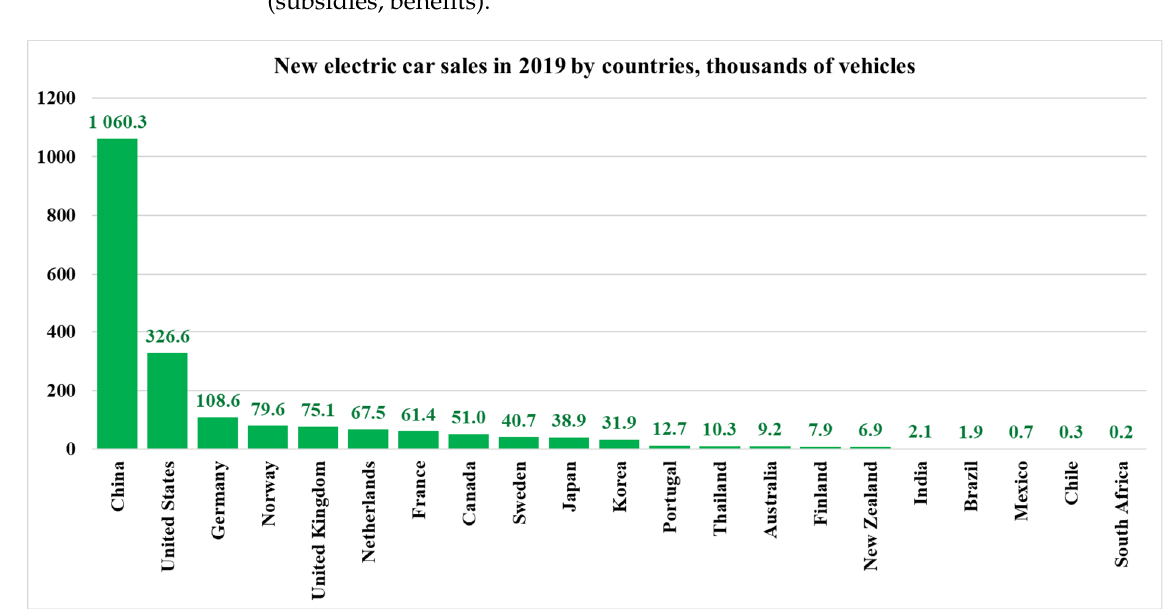
Figure 13. New electric car sales in 2019 by countries, thousands of vehicles [19] (p. 248).